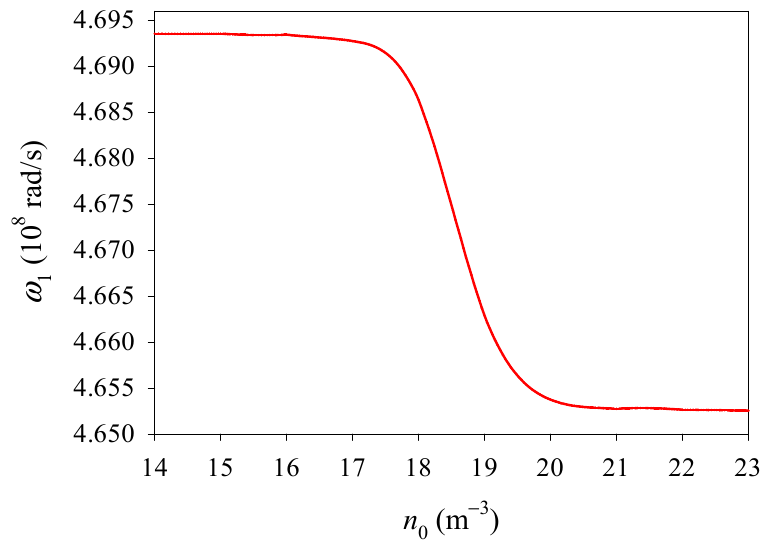
Figure 5. The first natural frequency ω 1 versus initial electron concentration n 0 . The distributions of the electromechanical fields along the line y = d /2 were analyzed.